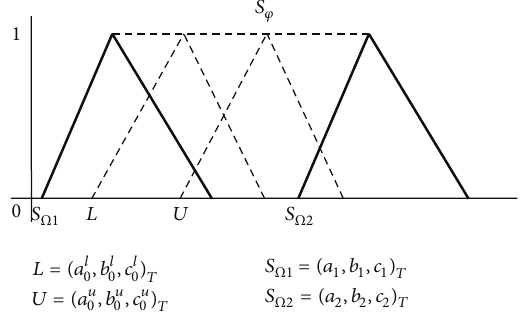
Figure 3: Graphical representation of confidence interval for 𝐻 1 (graph for 𝑆 1 ).